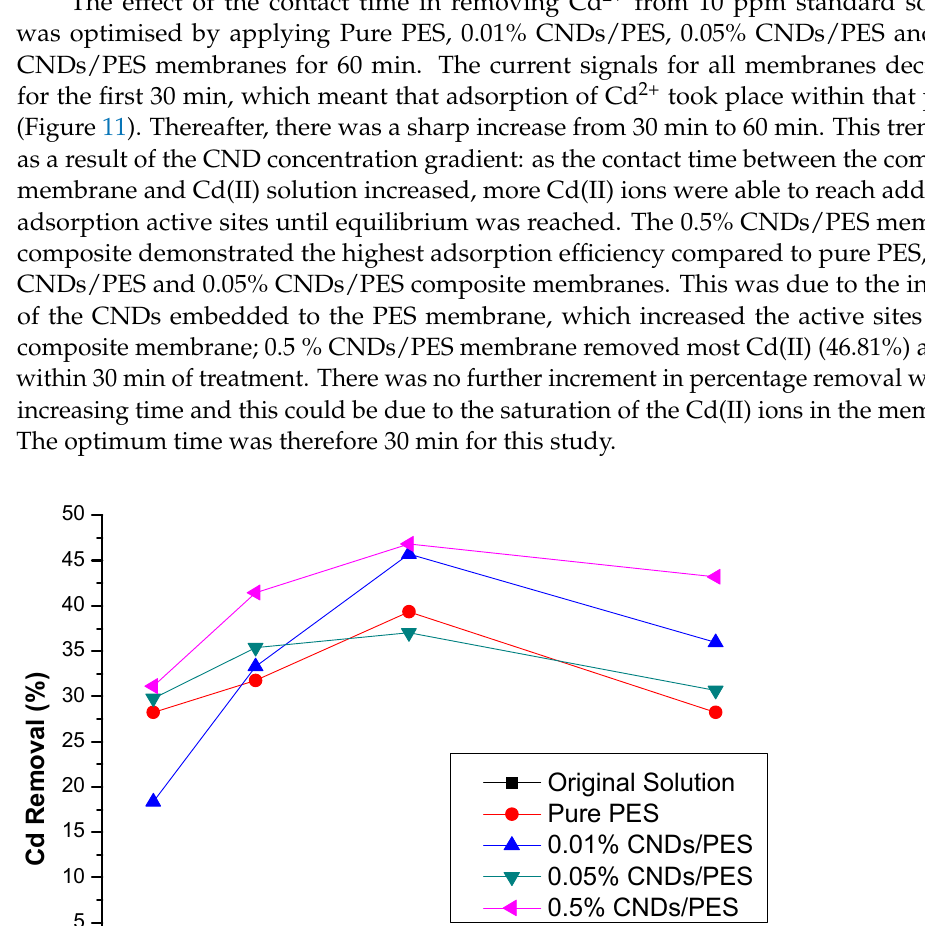
Figure 11. Effect of contact time for the removal of cadmium(II) from standard solutions. Different standard concentrations of Cd 2+ (0.5 ppm, 1 ppm, 1.5 ppm, 5 ppm and 10 ppm) were used in determining the percentage adsorbed for Cd(II) ions for 30 min at pH 5 using the different membrane composites. As observed in Figure 12, the percentage